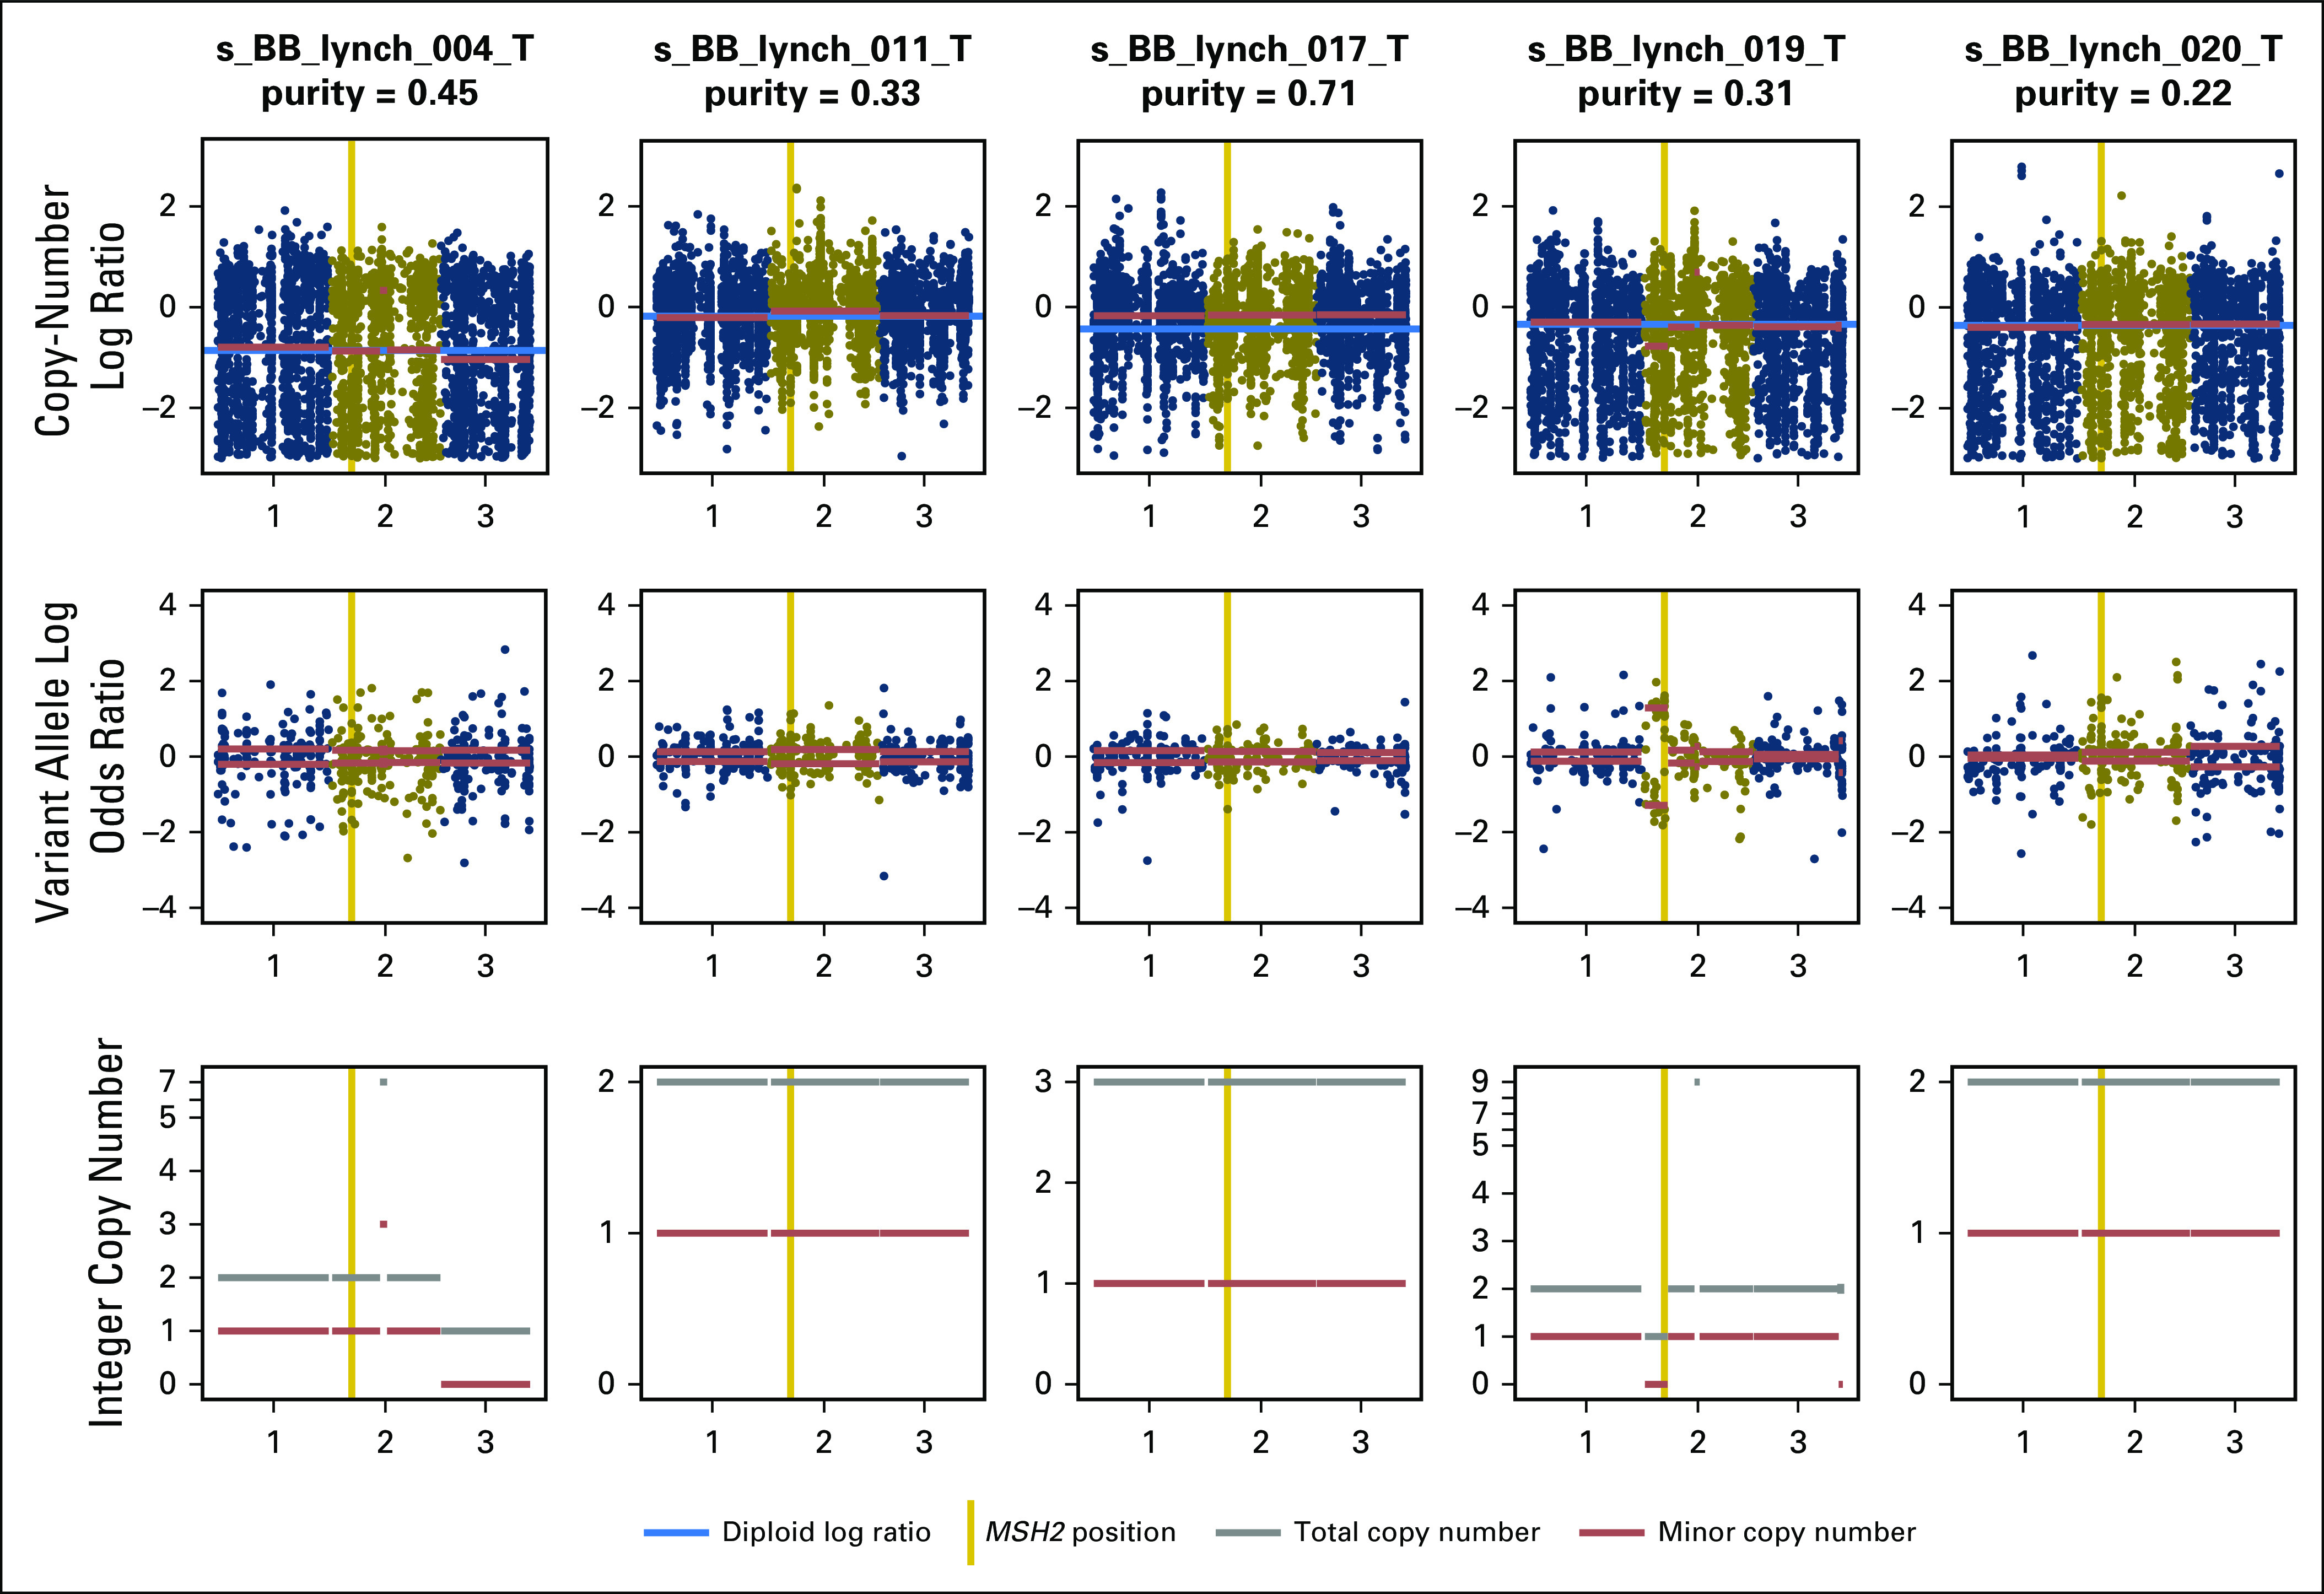
FACETS analysis of five samples without somatic alterations corresponding to germline mutations identified in mismatch repair genes. Sample s_BB_lynch_019_T was found to present loss of heterozygosity in MSH2.